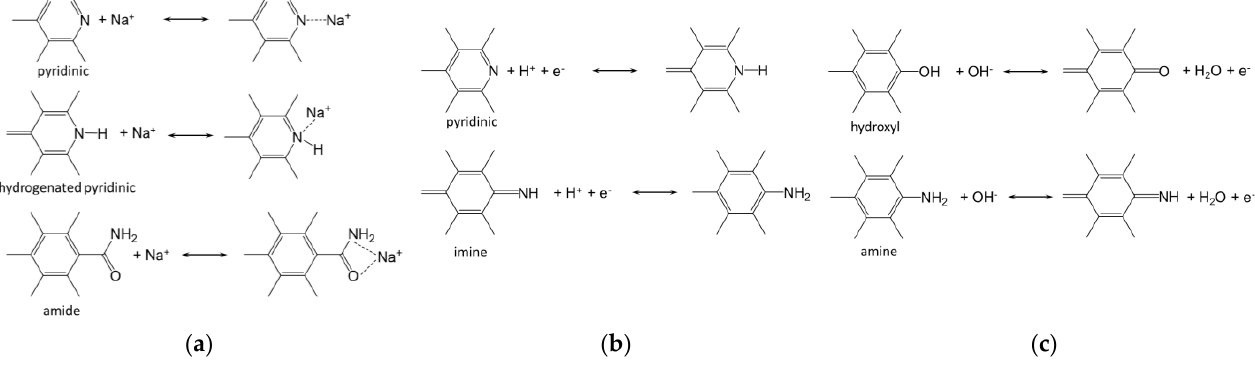
Figure 7. Assumed reversible redox reactions involving functional groups of NC in ( a ) SIBs and SCs in ( b ) acidic electrolyte and ( c ) alkaline